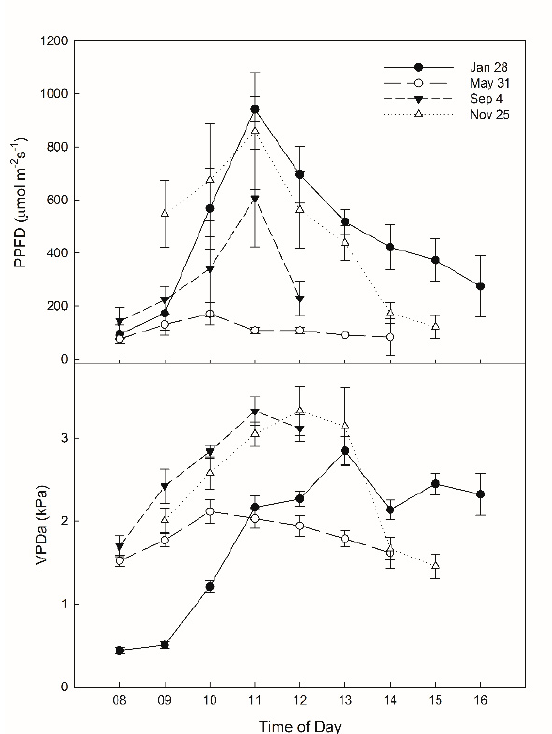
Figure 2. Diurnal variation of light intensity (PPFD) and vapor pressure deficit (VPD a ) on 28 January, 31 May, 4 September, and 25 November, 2011. N = 3, bars indicate ± standard error. The daytime CO 2 assimilation, nighttime respiration, and LAI are shown in Figure 4. CO 2 assimilation in the wet season was significantly higher than that in the dry season, with the yearly maximum in September (160.9 g CO 2 ) and the minimum in February (6.7 g CO 2 ). The daytime carbon sink capacity of trees was lower than the nighttime respiration from January to March. In this study, the single tree nighttime respiration ranged from 14.6 to 85.6 g CO 2 . Higher dark respiration and light compensation point values with lower A max and light saturation point were observed in the dry season. LAI represented the tree canopy dynamics and frequently fluctuated with seasons. LAI showed high values in spring and summer, thus represented seasonal variation in Z. serrata . However, the experimental area was struck by an intense typhoon in August, causing serious defoliation and low LAI. The difference between the fluctuations in leaf assimilation and monthly CO 2 assimilation was mainly caused by the monthly variation in leaf area (Figure 5). The monthly leaf assimilation rate ranged from 0.88 to 4.17 µ mol m − 2 s − 1 . The single-tree annual CO 2 assimilation was 23.79 kg. Z. serrata carbon assimilation was estimated as 3.50 Mg C ha − 1 year − 1 in the study area. CO 2 assimilation in the dry season was 56% that of the wet season, mainly caused by higher daytime assimilation and lower nighttime respiration in the wet season than in the dry season (Figure 6). Results also indicated that drought suppressed photosynthesis more than